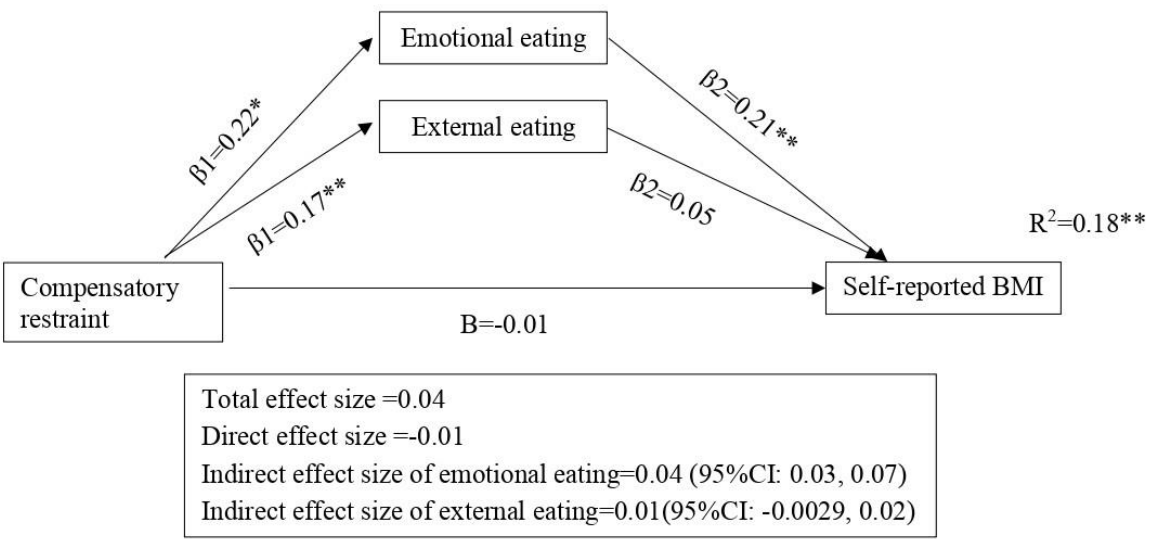
Figure 2. Emotional and external eating as the mediators in the association between compensatory restraint and self-reported BMI. Standardized beta coefficients (except for R 2 ) are shown on the arrows. The models are adjusted for age and gender. * p < 0.05 ** p < 0.01.